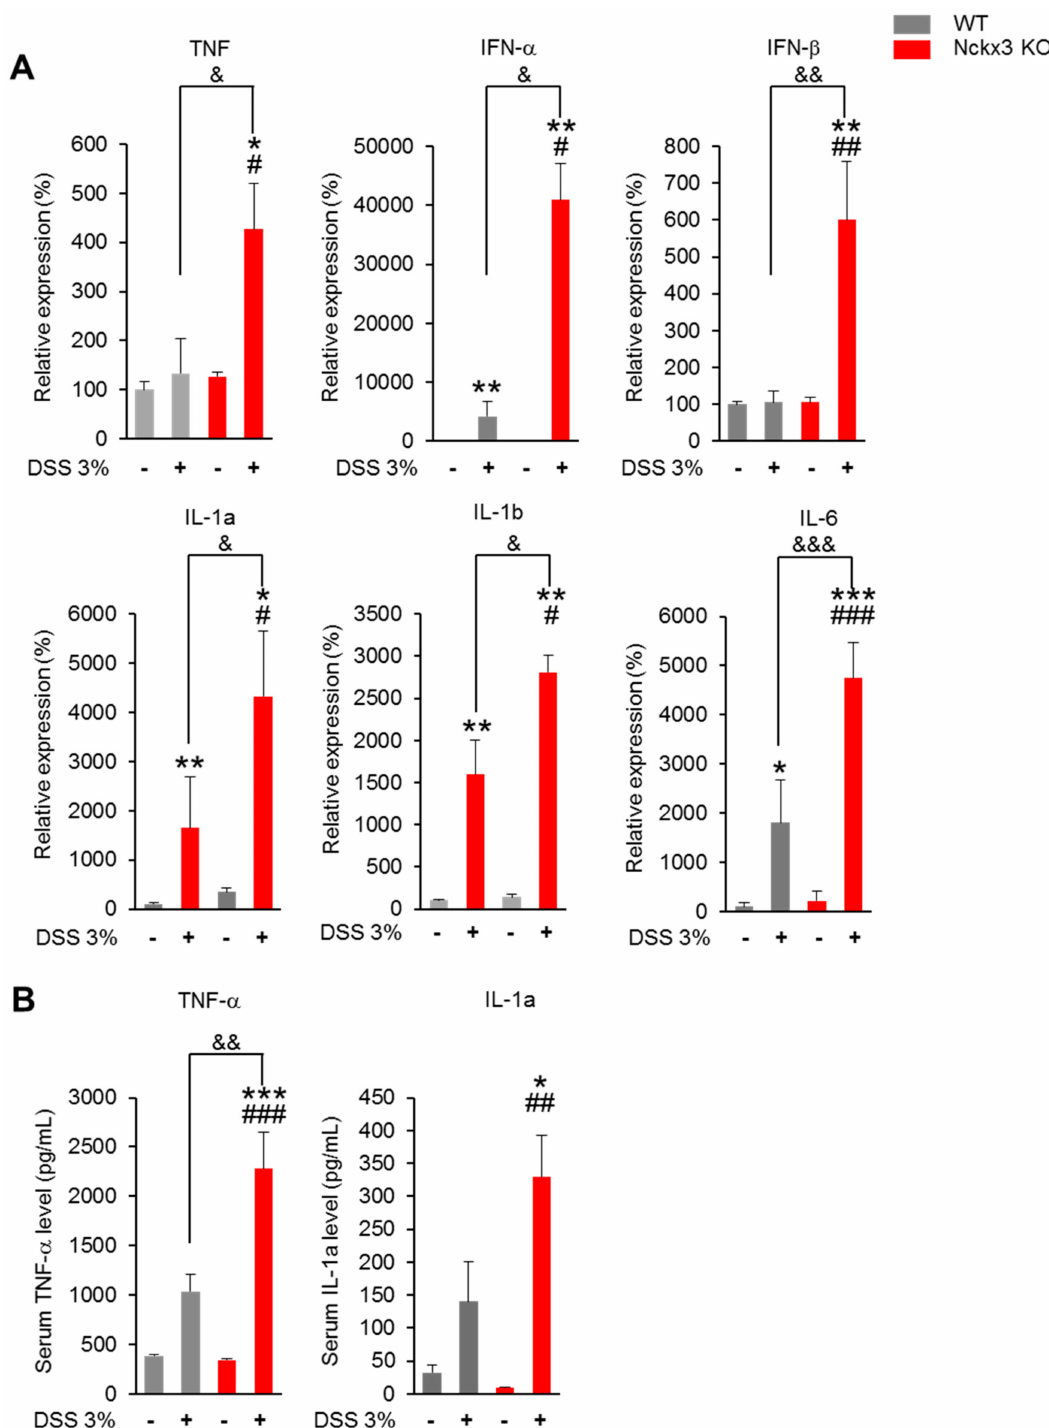
Figure 5. Nckx3 upregulated NF- κ B signaling in colitis mice. ( A ) Compared with the WT + DSS group, the Nckx3 KO + DSS group exhibited increased IL-6 , TNF- α , IL-1 β and IL-17a mRNA expression levels in the colon; ( B ) compared with the WT + DSS group, the Nckx3 KO + DSS group exhibited increased TNF- α and IL-1a concentrations in serum (n = 10 per genotype). Data represent the mean ± SEM. Statistical significance was determined by one-way ANOVA with Bonferroni correction. * p < 0.05 vs. WT, ** p < 0.01 vs. WT Nckx3 KO, ** p < 0.001 vs. WT, *** p < 0.001 vs. WT, # p < 0.05 Nckx3 KO + DSS vs. Nckx3 KO, ## p < 0.01 Nckx3 KO + DSS vs. Nckx3 KO, ### p < 0.001 Nckx3 KO + DSS vs. Nckx3 KO, & p < 0.05 WT + DSS vs. Nckx3 KO + DSS, && p < 0.01 WT + DSS vs. Nckx3 KO + DSS, &&& p < 0.001 WT + DSS vs. Nckx3 KO +